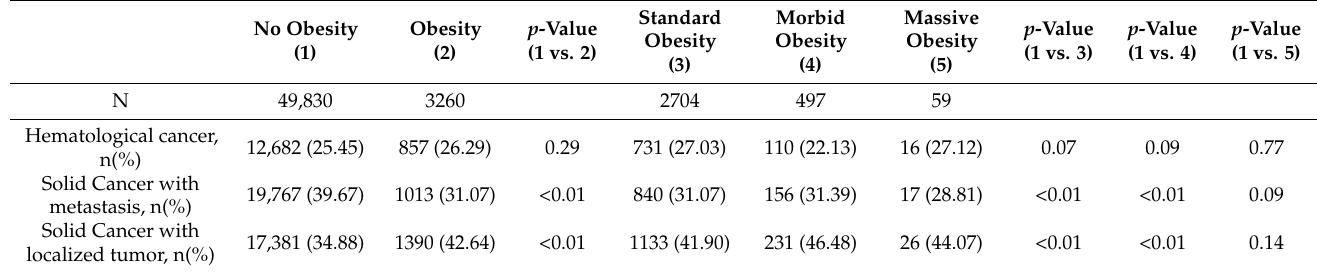
Table 2. Type of cancer by obesity among COVID-19 cancer